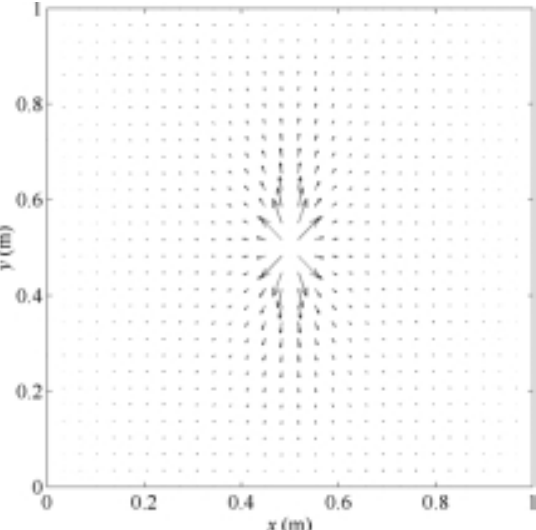
Fig. 13. The classical intensity field in the orthotropic plate when f = 5 kHz and η = 0 . 02 .